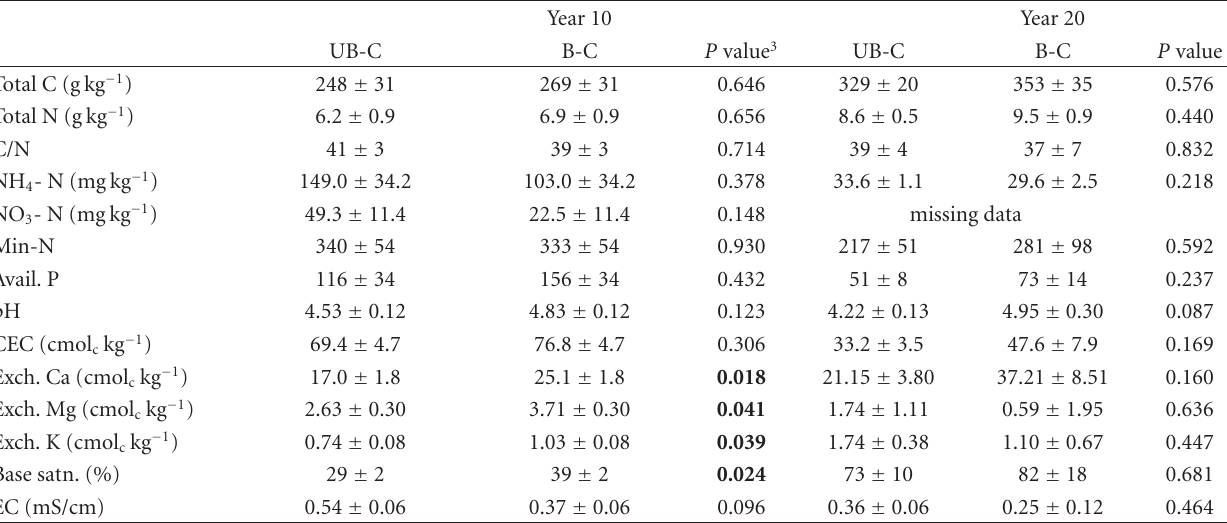
Figure 1: Soil carbon content (Mgha − 1 ) in years 10 and 20 in (a) unburned and burned control forest floor and (b) unburned and burned mineral soil to a depth of 10 cm. Error bars are one standard error. Refer to Table 1 for treatment abbreviations. Table 2: Broadcast burning 1 e ff ects 2 on forest floor chemistry after 10 and 20